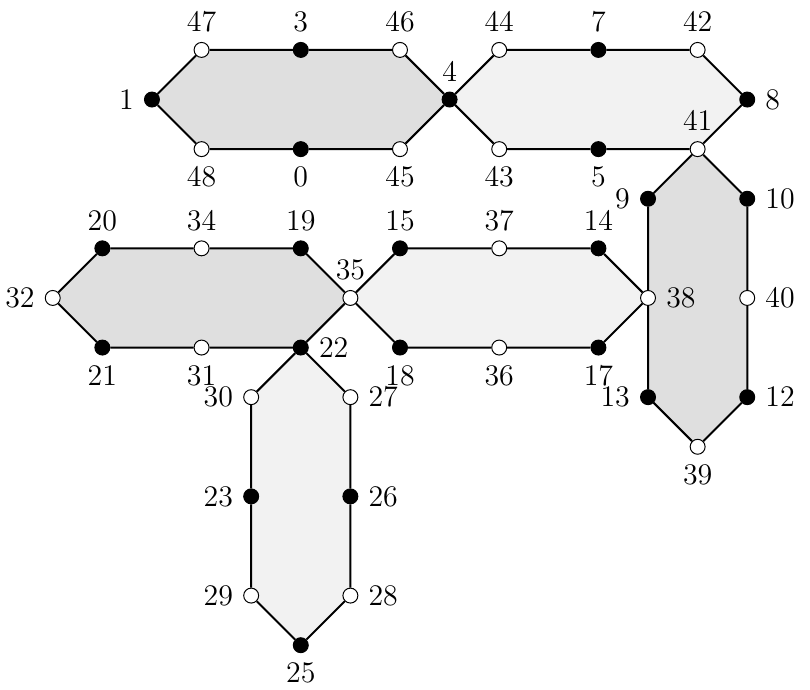
Figure 2: An α -labeling of a 6 C